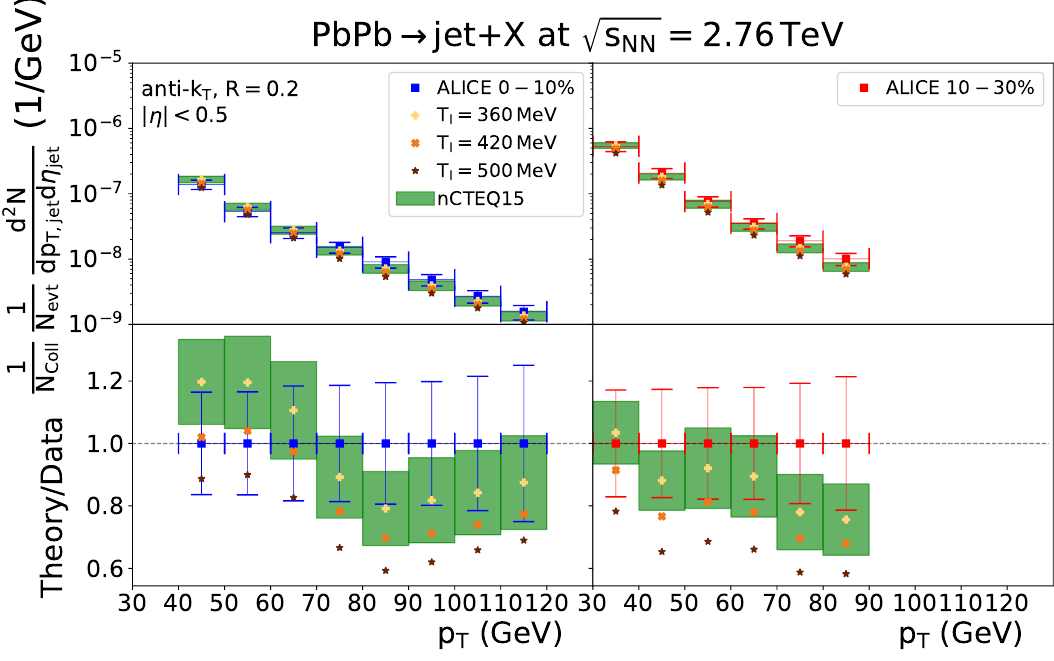
Figure 9 . Dependence of the jet yield in 0–10% (left) and 10–30% (right) central PbPb collisions √ as observed by ALICE at s NN = 2 . 76 TeV on the initial temperature T I of the QGP. The default value in JEWEL for T is 360 MeV . The PDF variations correspond to the green shaded I